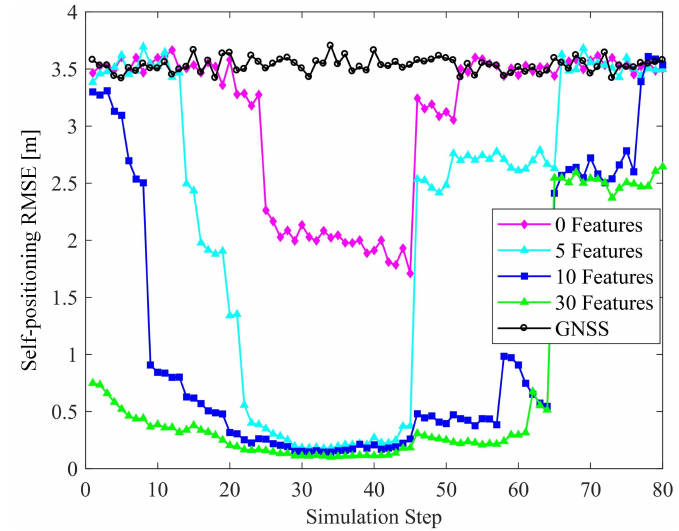
Figure 12. Effect of the number of features on localization